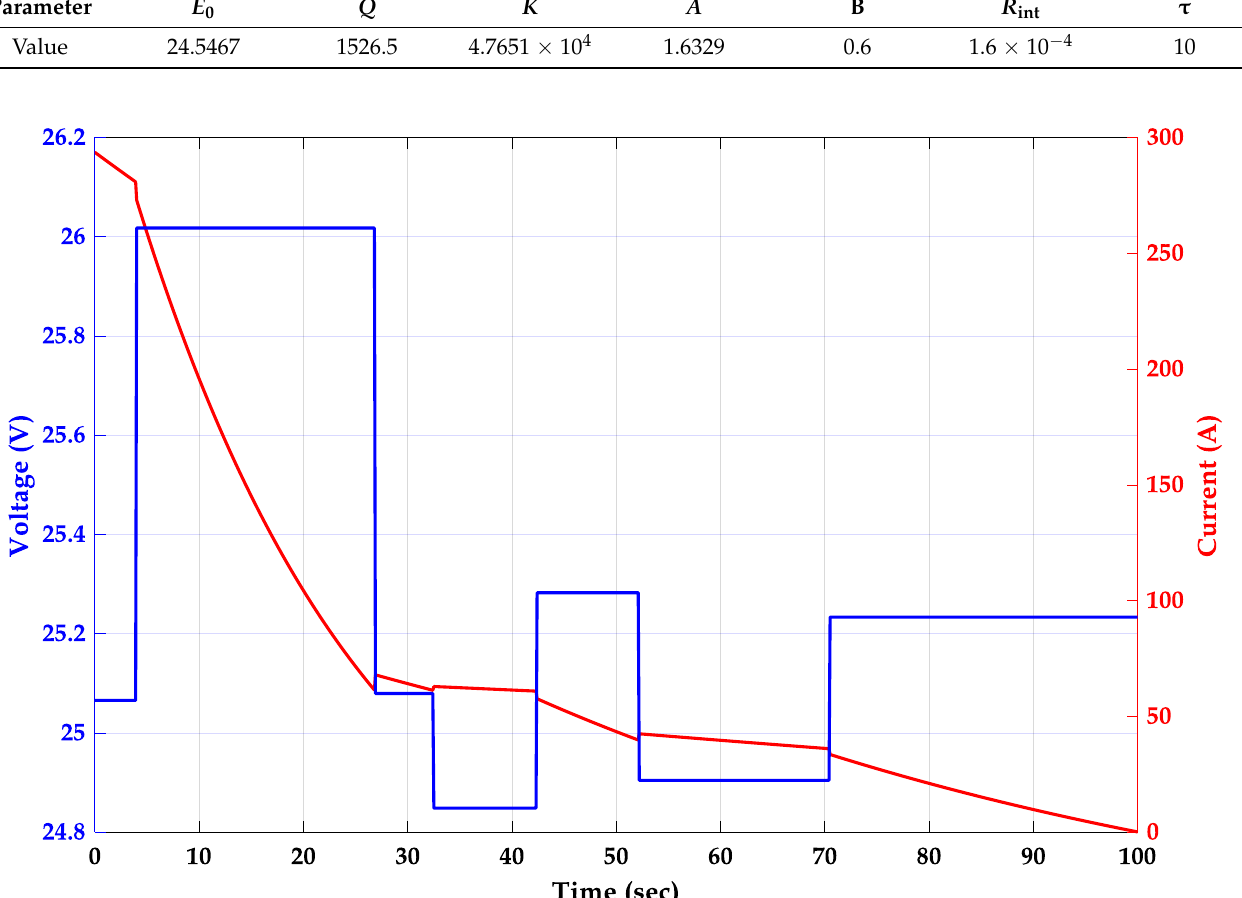
Figure 2. Lead-acid battery data: current and voltage.